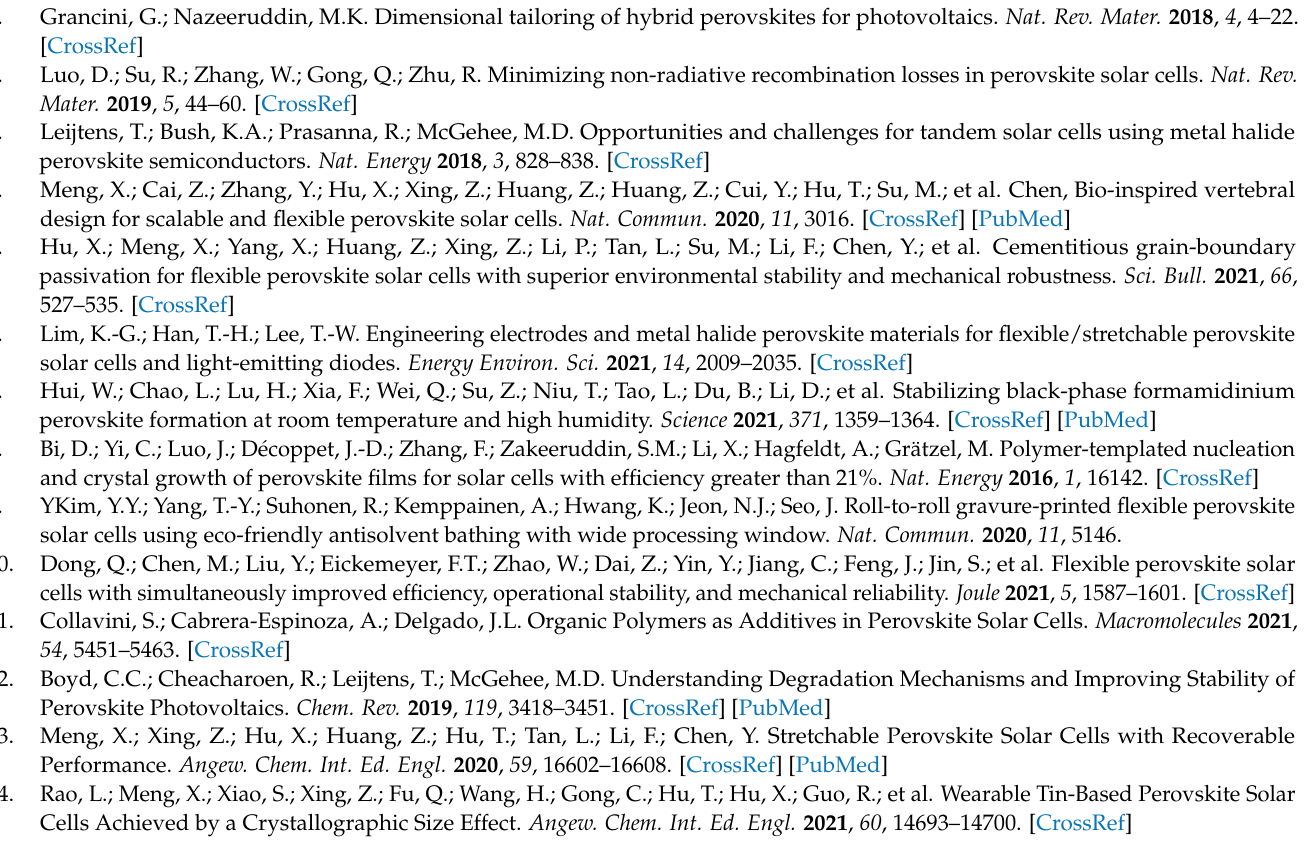
Figure S2. Digital photographs showing the healing of the fractured PAT elastomer. (a) Orignal. (b) Cut sample. (c) Healed sample. (d) Stretched sample. Figure S3. Typical stress-strain curves of the intact, 10 min, 30 min and 1 h healed PAT elastomers at 25 °C. Figure S4. The contact angle measurements. (a) Contact angle of Pristine perovskite films. (b) Contact angle of Doped perovskite films. Figure S5. Cross-section view of pristine and doped perovskite films. Figure S6. XRD spectrum of pristine and doped perovskite films. Figure S7. PCE tests of SPSCs with different PAT concentration. Figure S8. Stability tests of sealed cells. (a) Un-encapsulated cells with and without PAT with a RH level of approximately 80% and dark environment. (b) Under simulated solar light (AM 1.5; 100 mW/cm 2